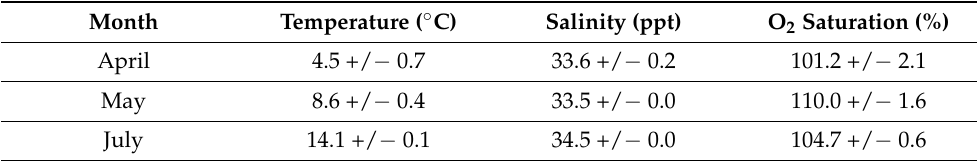
Figure 6. Three examples of echograms of volume backscattering strength (S V ) at 333 kHz collected by WBT Mini on the Sailbuoy in the upper 100 m and integrated over a 24 h period. The echograms display differences in zooplankton aggregation during the three periods and regions of the 2018 deployment. ( A ) April, deep and thin registrations in Vestfjord, ( B ) June, persistent dense layer in the upper 10–30 m, along the western coast of Vesterålen, ( C ) August, wide vertical distribution with indications of diel vertical migration, along the shelf break. Table 2. Average and standard deviation of monthly temperature, salinity, and oxygen saturation measured from the Sailbuoy glider, from April to July